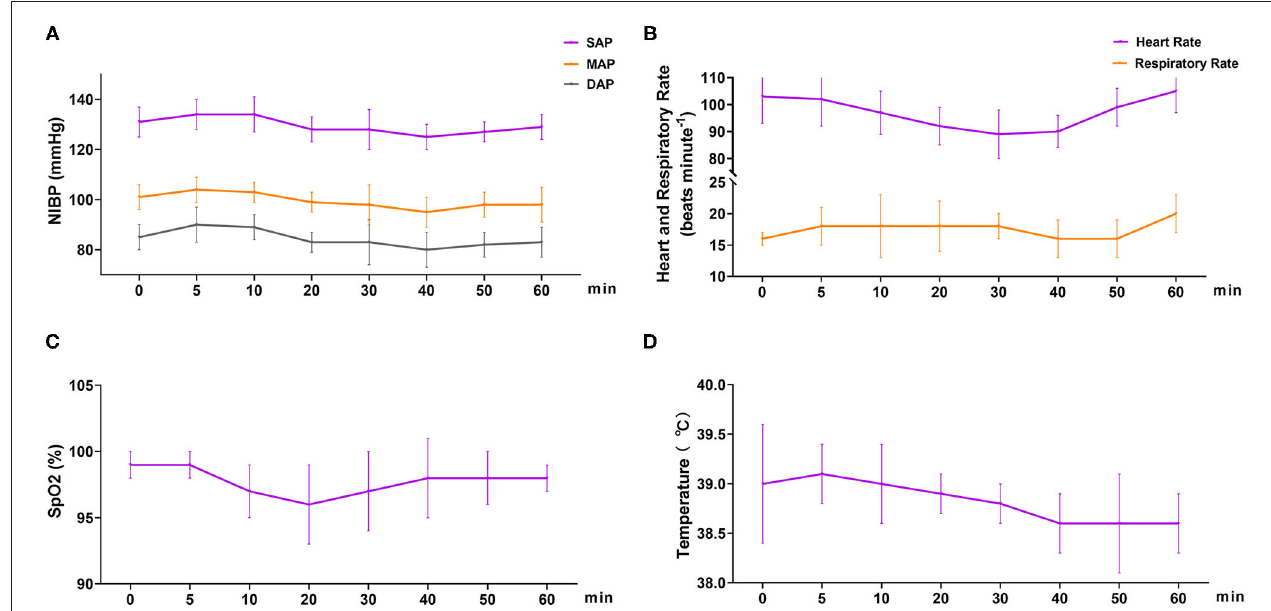
FIGURE 4 | Cardiopulmonary variables in dogs ( n = 6) undergoing orchiectomy administered with 10 µ g kg − 1 dexmedetomidine and 4.5mg kg − 1 tiletamine intramuscularly at Phase 2. (A) Systolic arterial pressure (SAP), mean arterial pressure (MAP), and diastolic arterial pressure (DAP); (B) heart rate (HR) and respiratory rate ( f R ); (C) peripheral hemoglobin oxygen saturation (SpO 2 ) and (D) temperature (T). Values are expressed as mean ± standard deviation (SD). *Significantly different from 0min at the same group ( p <